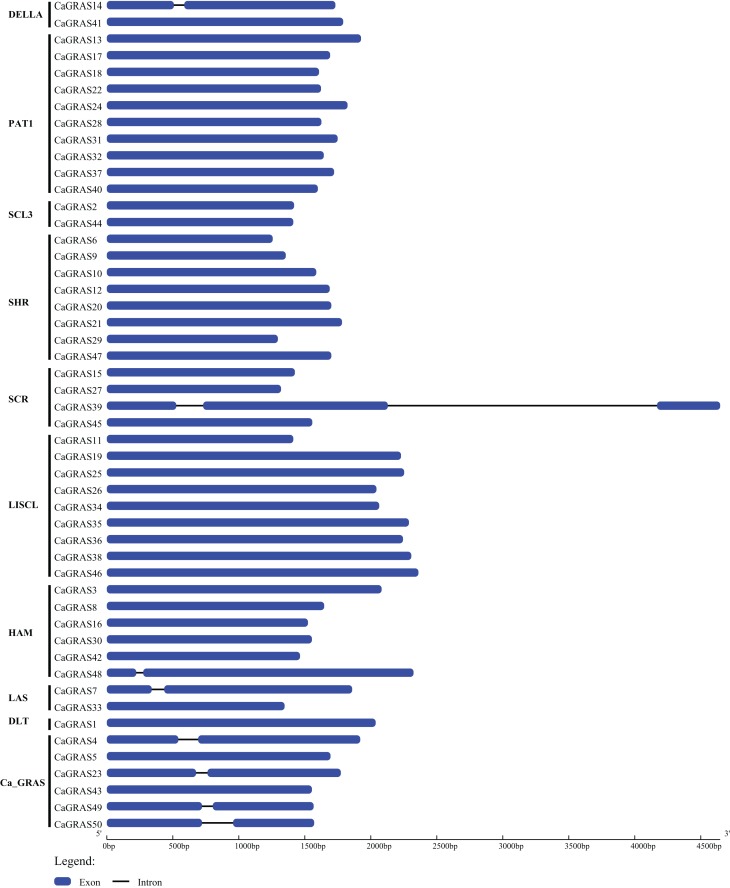
Exon-intron structure of CaGRAS genes.Blue box indicates exon, and black line indicates intron. Y-axis represents the subfamily name of each CaGRAS genes. The lengths of the exons and introns were drawn to scale.